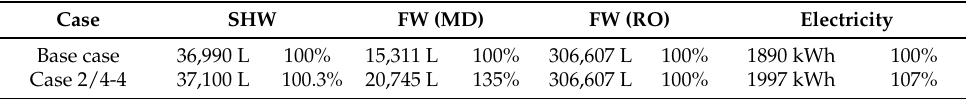
Table 10. Results comparison between base and optimum (MD) case.